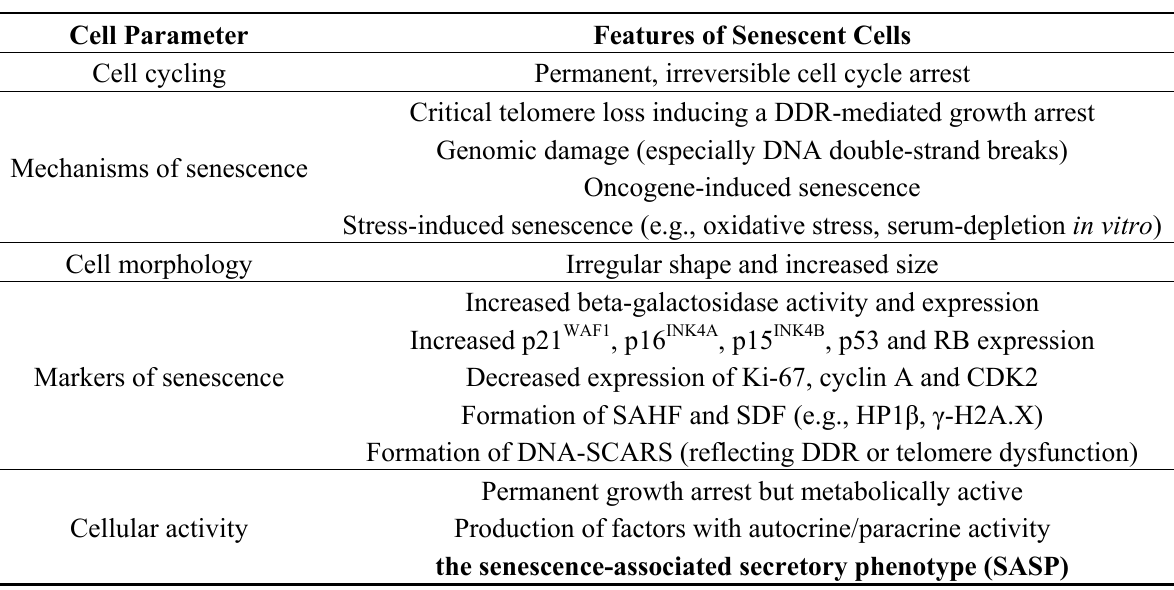
Table 1. Features of senescent